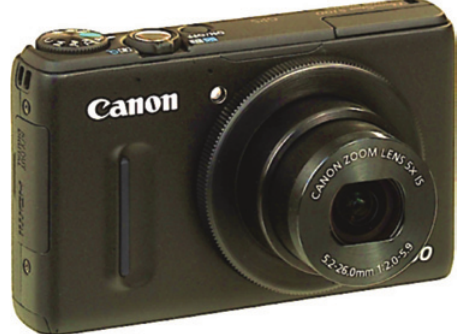
Fig. 3. Consumer camera Canon S100 mounted at